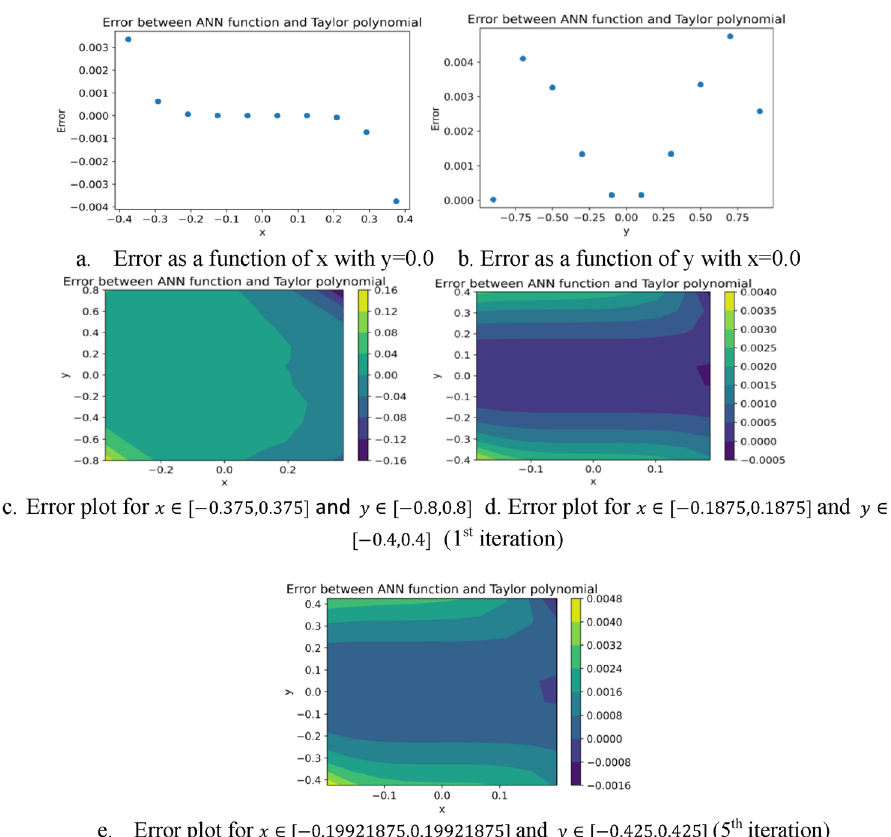
Fig. 9 Illustration of algorithm for computation of acceptable region of approximation for two variable function